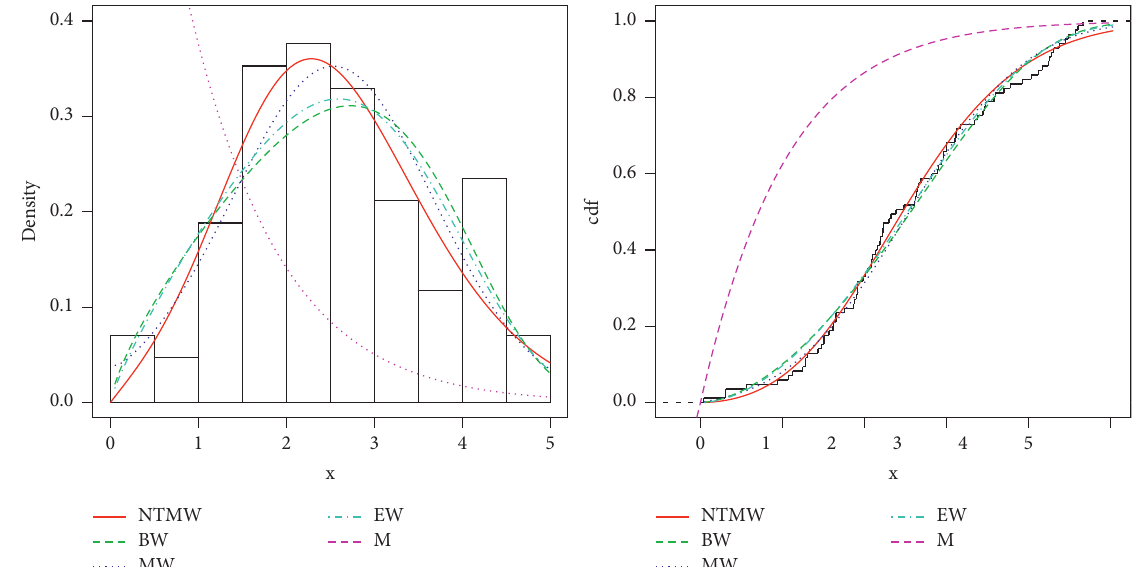
Figure 3: Estimated pdfs (a) and estimated cdfs (b) for the considered models for dataset